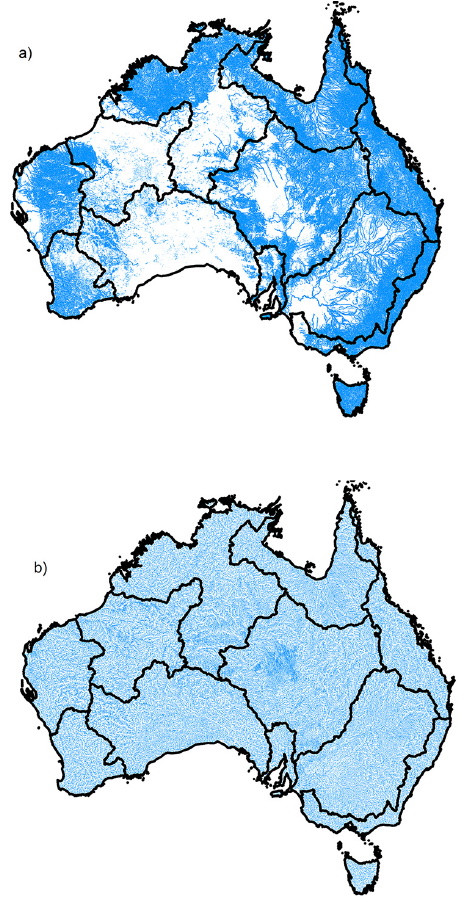
Figure 8. The stream network delineated by (a) this study and (b) that supplied by the HydroSHEDS database. Level 1 drainage divi- sions are indicated by the bold black